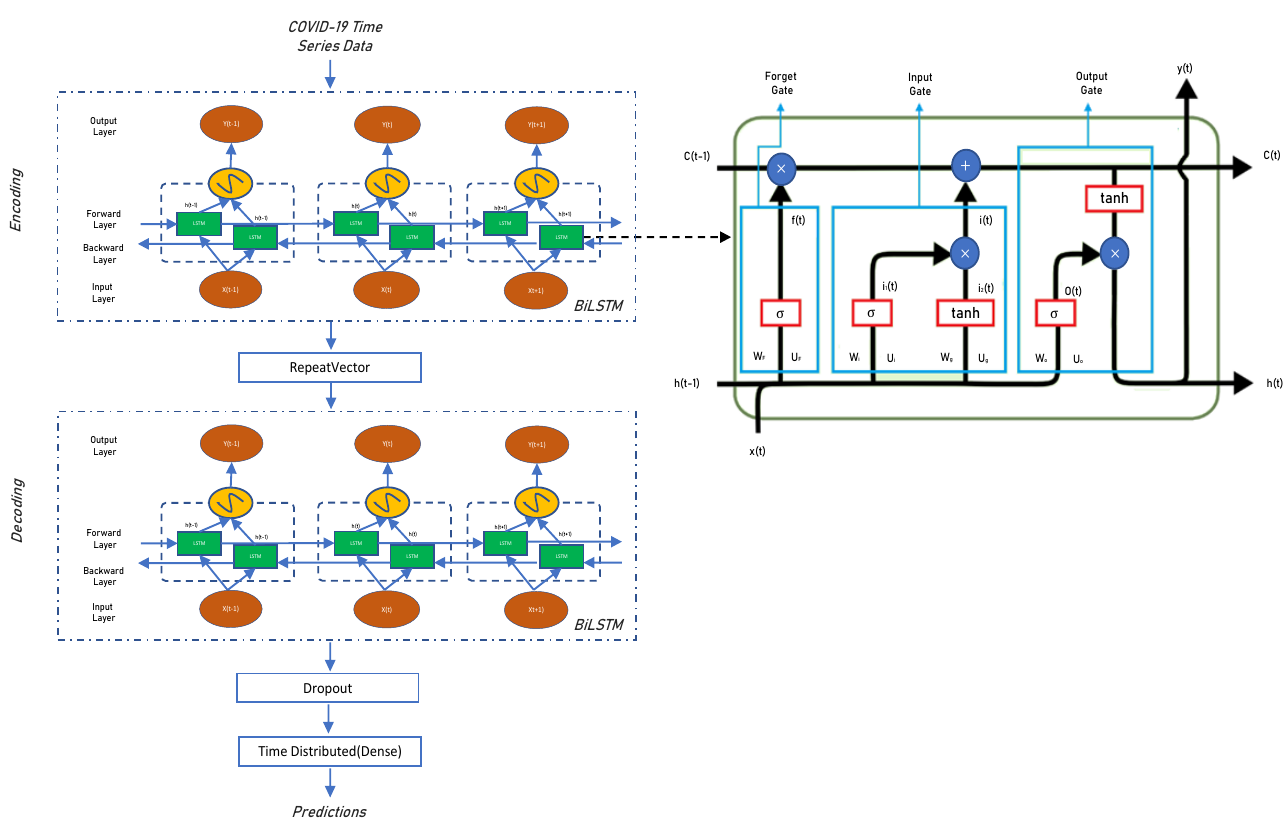
Figure 2. Our proposed architecture for COVID-19 time series prediction. LSTM consists of a cell current state with three gates: input, output, and forget, as shown in Figure 2. The cell state is the network memory responsible for retrieving the sample along the input sequence. The input gate determines the relevant information to add the previous time steps. The forget gate keeps the previous time step and determines how the previous memory remembers and forgets. Finally, the output gate decides the value of the current time